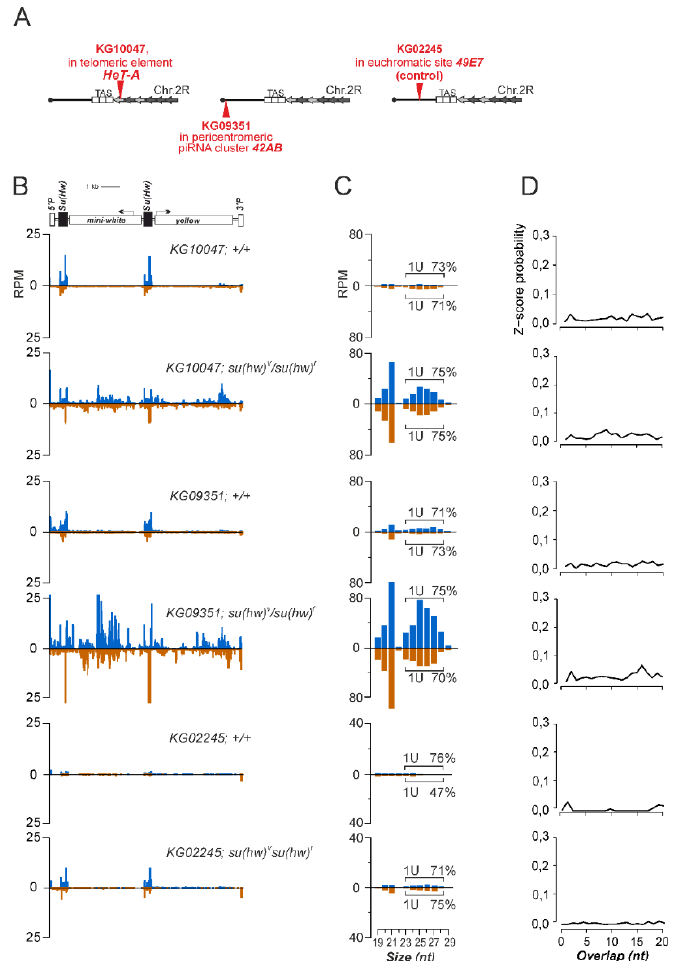
Figure 1. Generation of small RNAs by transgenes containing Su(Hw)-binding sites and located in piRNA clusters. ( A ) Schematic representation of transgenic insertion sites. Insertion sites of transgenes are indicated as triangles situated either up or below the schemes, which correspond to their genomic orientation. ( B ) Scheme of SUPor-P construct is shown above. Normalized numbers of small RNAs (19–29 nt, in reads per million, RPM) mapped to transgenic constructs (blue—sense; brown—antisense; no mismatches allowed) in wild type Drosophila ovaries and in su(Hw) V /su(Hw) f mutants. ( C ) Length distribution of transgenic small RNAs. Percentage of transgenic reads excluded Su(Hw) sites having 1U is indicated for each strand (only 24–29-nt reads were considered). ( D ) Relative frequencies (Z-score) of 5′ overlap for sense and antisense 24–29-nt transgenic piRNAs excluded Su(Hw) sites (ping-pong signature).